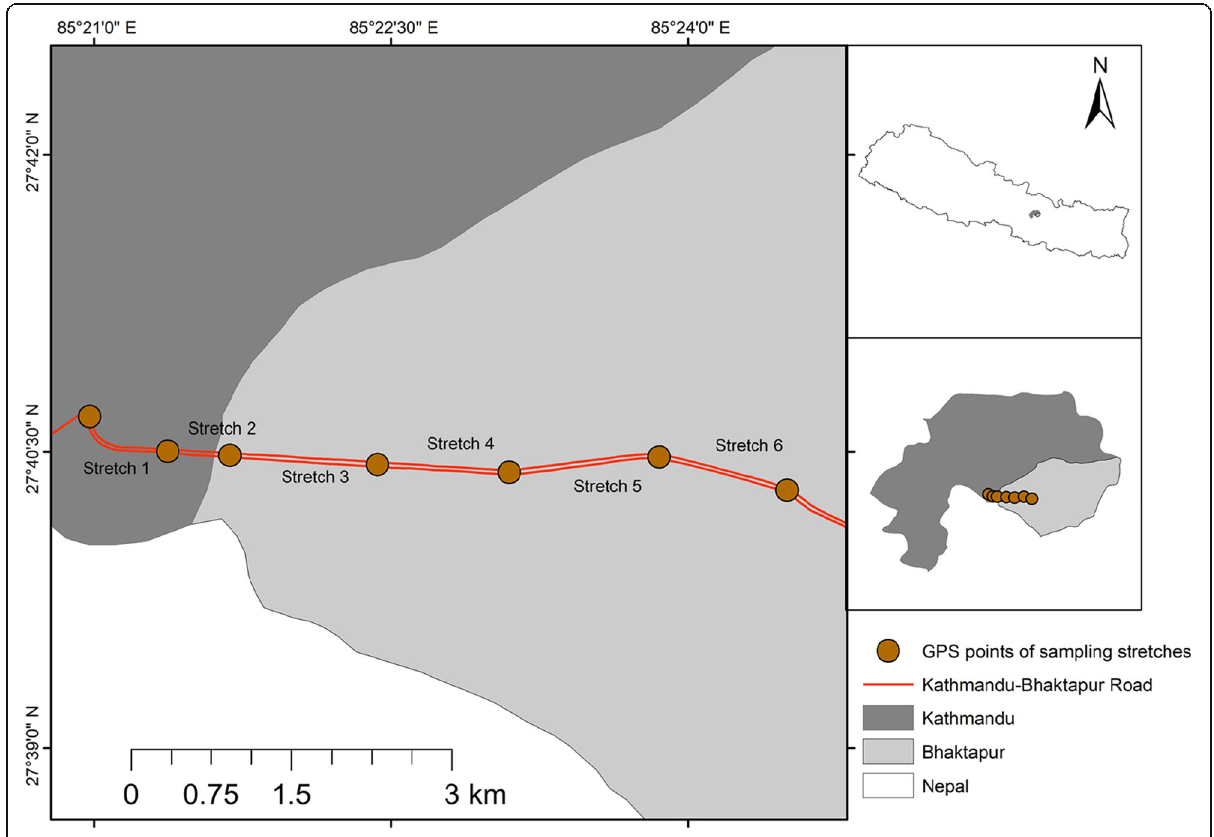
Fig. 1 Map of study area with sampling stretches (Araniko Highway: Kathmandu-Bhaktapur road,